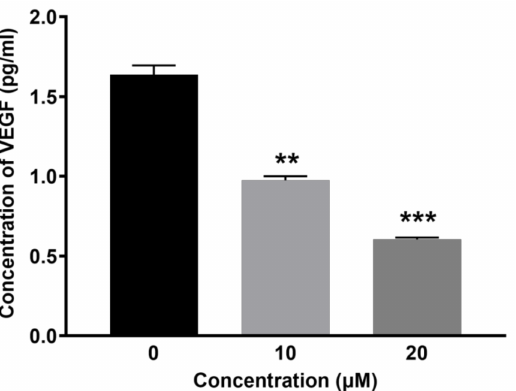
Figure 2. BCP inhibited VEGF secretion in vitro. Graphical representation of the levels of VEGF (pg/mL) after treatment of (0.5% DMSO), 10 and 20 µ M BCP with HUVECs for 6 h. Data was represented as mean ± SD ( n = 3), ** p < 0.01 and *** p < 0.001 compared to DMSO-treated control